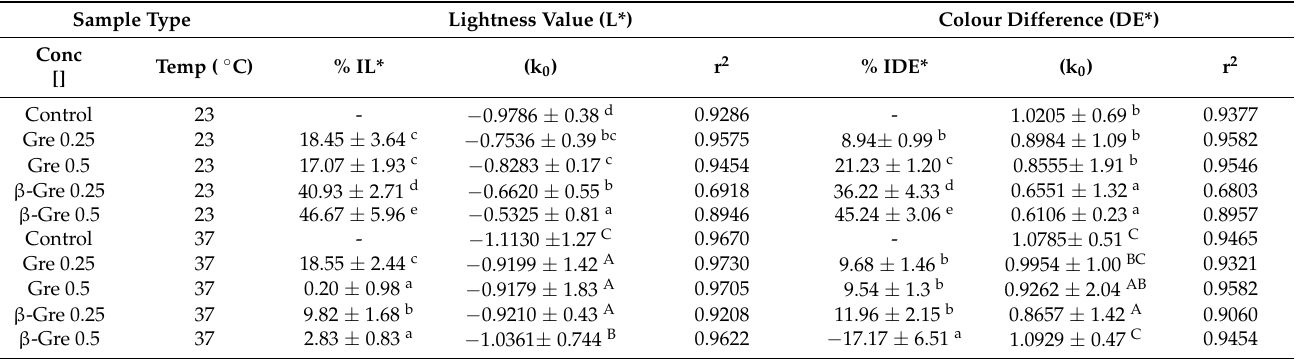
Table 1. Inhibitory capacity of green rooibos extracts against browning of canned apples during